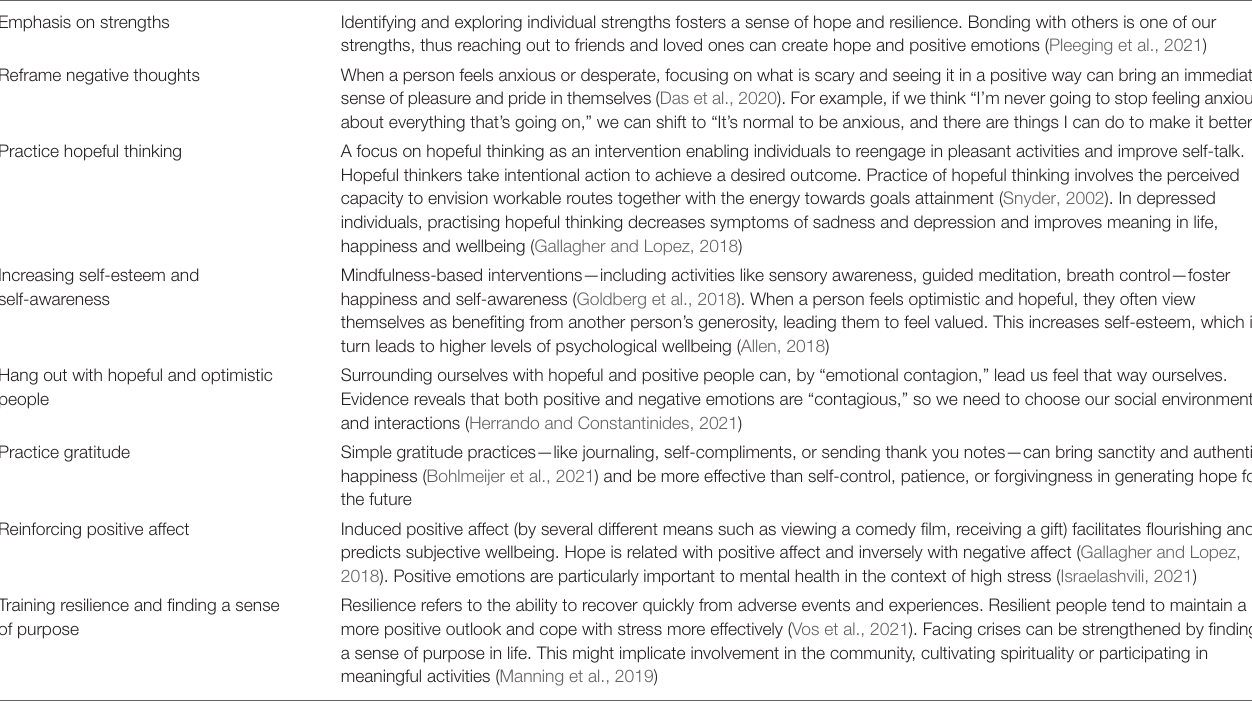
TABLE 1 | Strategies to cultivate a hope/optimism mind-set (based on Newport Academy, 2020). Emphasis on